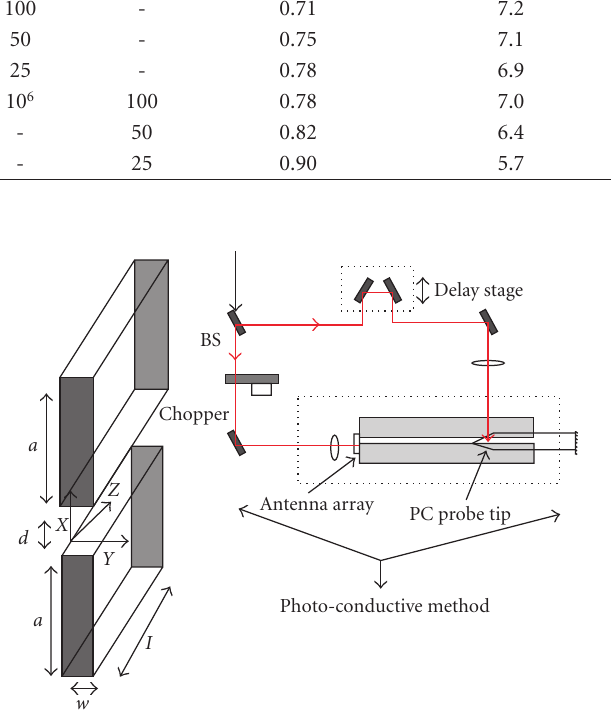
Figure 6: Waveguide goemetry: d = 270 μ m, w = 300 . 0 μ m, and l = 140 . 0